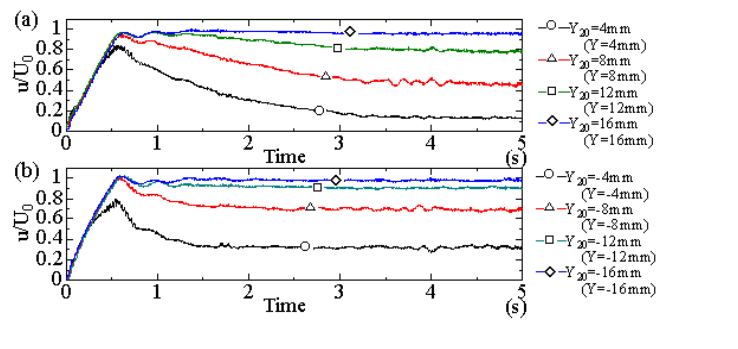
Fig. 2 Time series of u-velocity at X=20mm (natural); (a) upward,(b)downward.